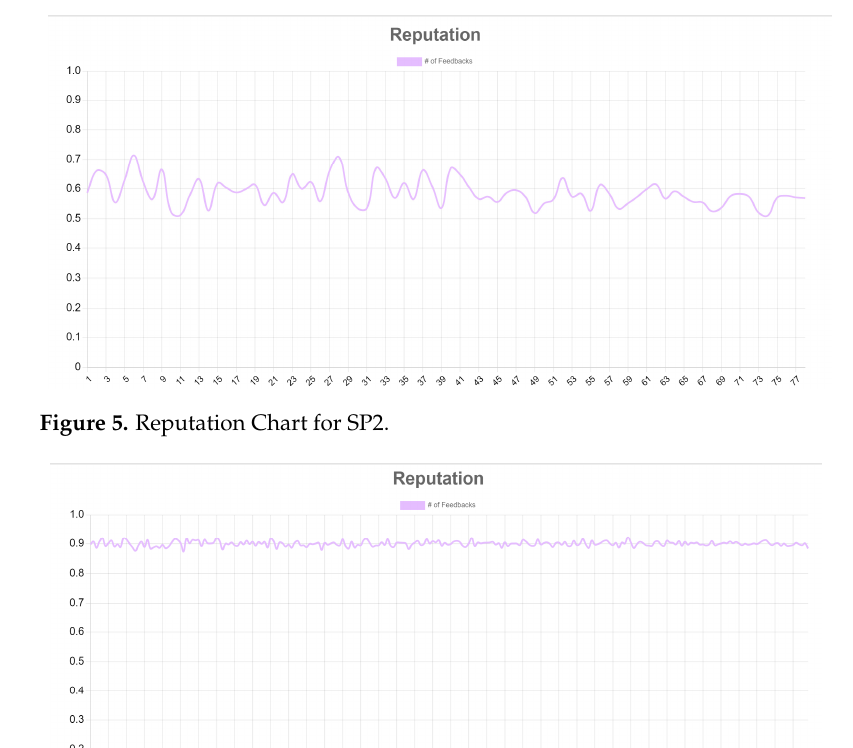
Figure 4. Reputation Chart for SP1.